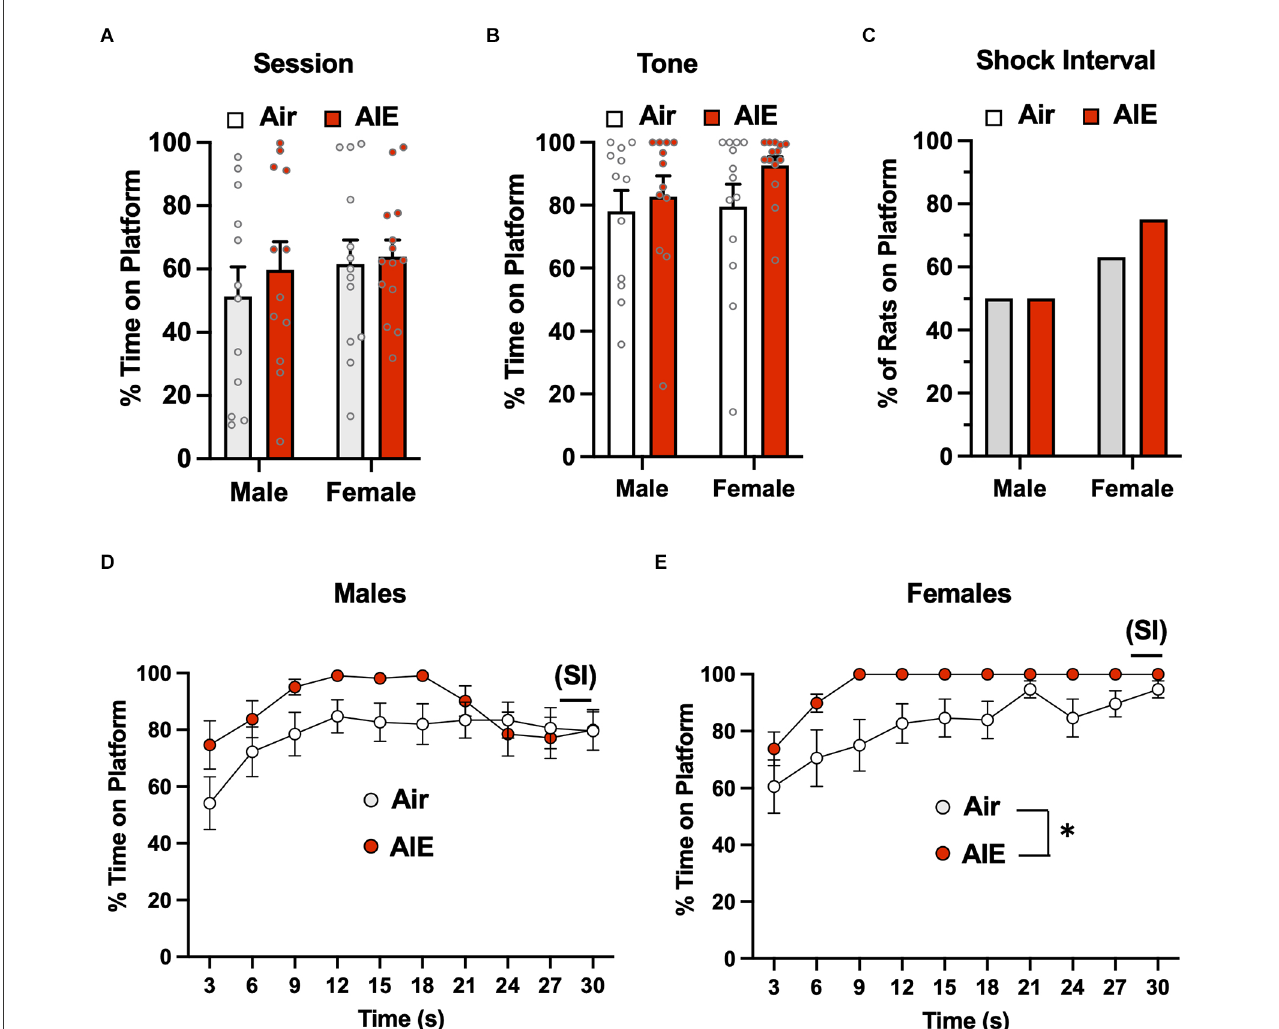
FIGURE4 Active avoidance behavior assessed on the first day of extinction of the platform-mediated avoidance task. When the percentage of time the rats were positioned on the platform was examined over the entire session (A) or only during the tone presentations (B) , there were no significant difference across sex or AIE. (C) Chi-square analysis indicated there were no differences in the percentage of rats considered to have remained on the platform during the 2-s shock interval (SI). Analysis of the time-course in 3 s bins of when the male (D) and female (E) rats were on the platform during the tone presentations revealed a significant main effect of time and a significant main effect of AIE in the female rats. Data represent the means ± sem (except for the contingency date in panel C ; n = 12–13/group). ∗ indicates a significant main effect of AIE, p = 0.046.